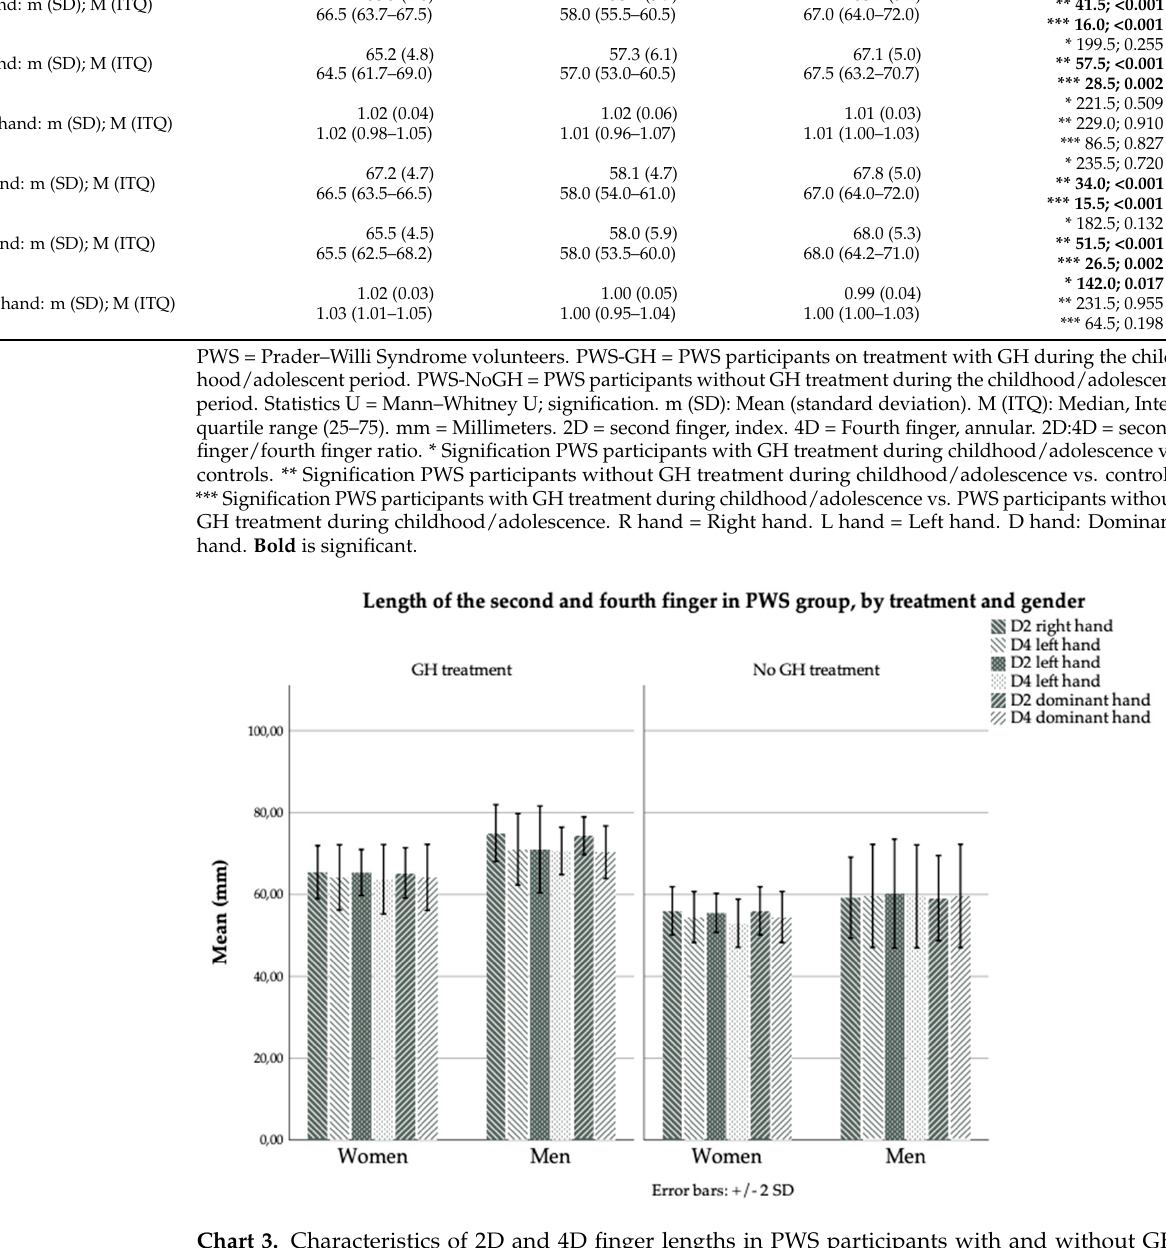
Chart 3. Characteristics of 2D and 4D finger lengths in PWS participants with and without GH treatment during childhood/adolescence, by